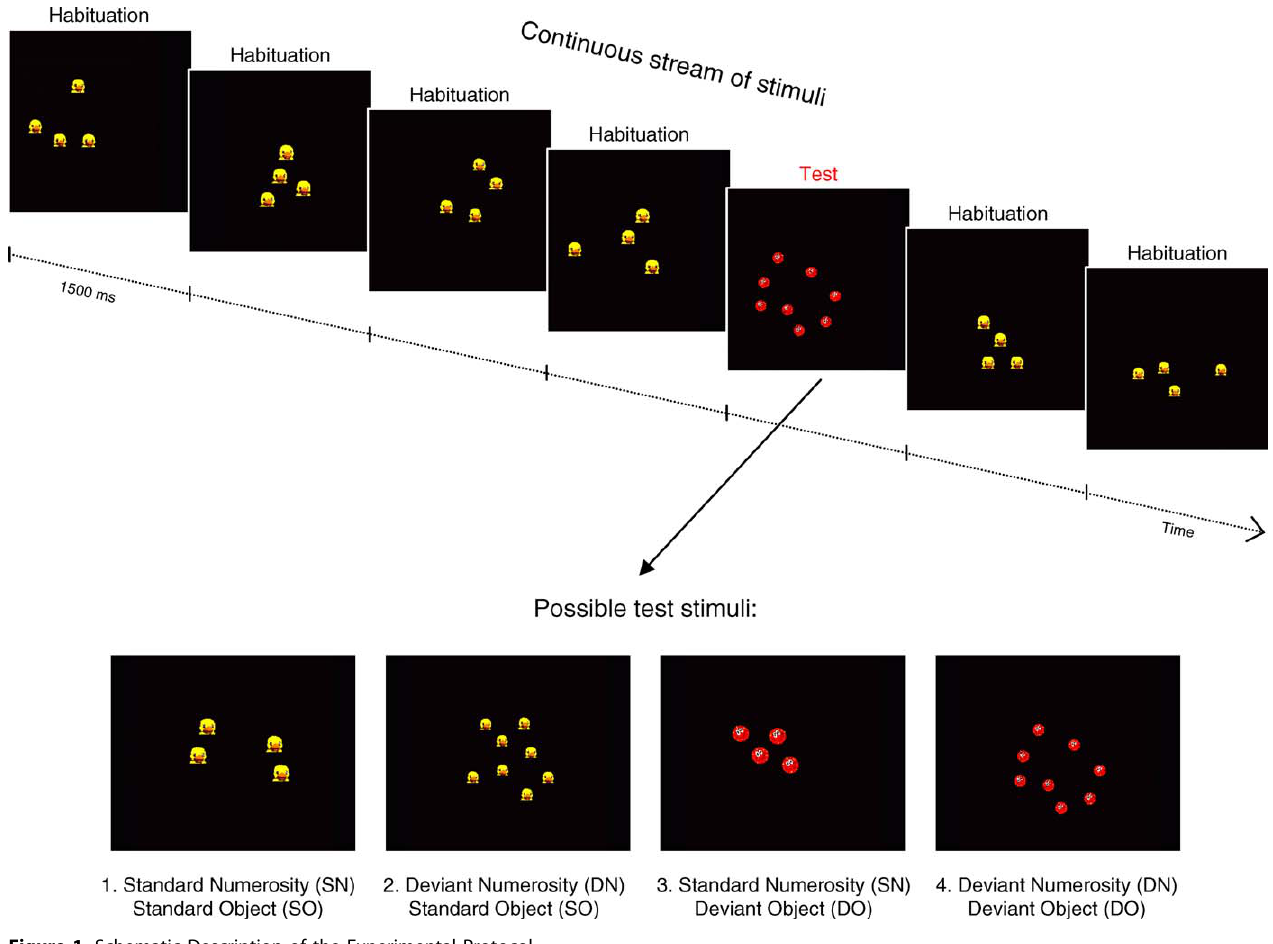
Figure 1. Schematic Description of the Experimental Protocol Infants were presented with a continuous stream of images, each depicting a set of objects. Within a given block, all habituation stimuli shared the same SN and object identity. Occasionally, a test stimulus was inserted that could differ in number and/or object identity. We only report ERPs to those test stimuli, averaged separately for standard versus deviant number trials, and for standard versus deviant object trials.